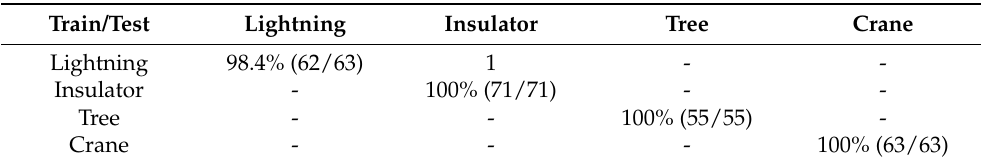
Table 10. Accuracy of the created decision tree w.r.t. interaction-curvature predictor selection on test set data for 70% training and 30%